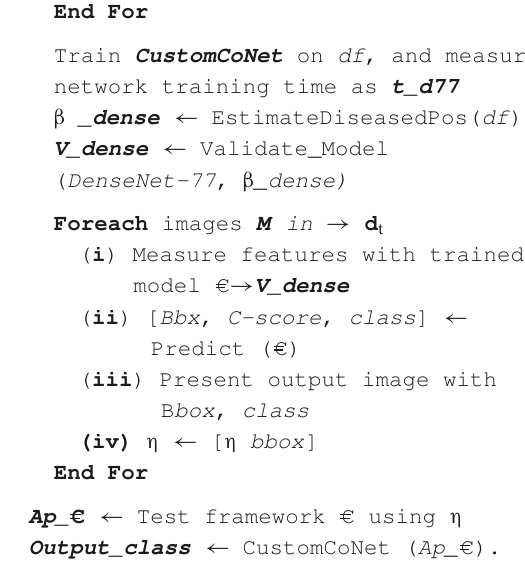
Algorithm 1. Description of steps followed by the proposed